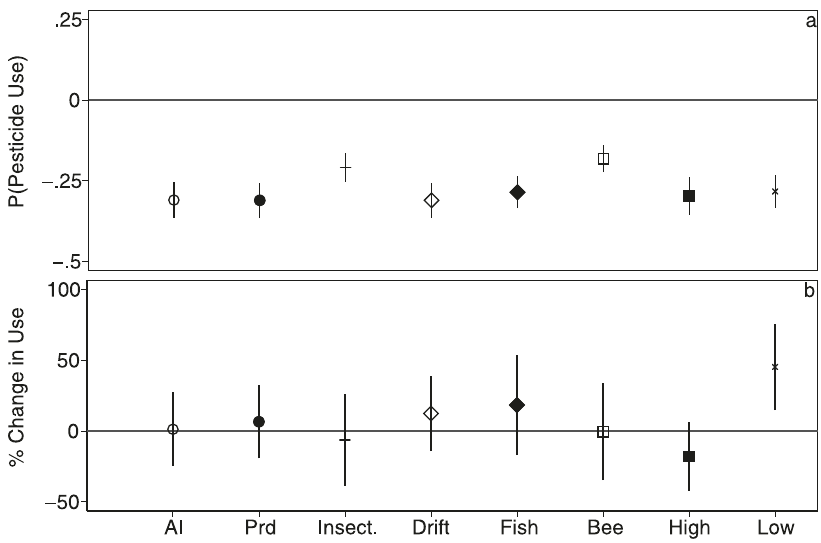
Fig. 4 Lognormal hurdles models correcting for estimated yield gaps following Ponisio et al. 15 . Correcting for yield gaps does not affect the fi rst hurdle ( a ), but does shift the coef fi cient estimates in the second hurdle up ( b ) relative to the unadjusted model (Fig. 2). Figure details are otherwise the same as Fig. 2. The x -axis indicates different pesticide use outcomes: kg ha − 1 active ingredients (AI), kg ha − 1 products (Prd), kg ha − 1 of products targeting insect pests only (Insect), kg ha − 1 of products with a propensity to drift (Drift), kg ha − 1 products of potential hazard to fi sh and bees (Fish, Bee), as well as products of higher (EPA signal word 1 – 2) and lower (EPA signal word 3 – 4) acute human toxicity (High, Low). Symbols indicate point estimates (mean) and error bars represent the 95% CI. All models include cluster robust standard errors clustered at the farm-by-crop family level. For the second hurdle ( b ), percent change is calculated from the log-level model as 100 ð e β (cid:2) 1 Þ and standard errors are derived using the delta-method implemented with the nlcom function in Stata. All models include covariates for fi eld size, farm size, and soil quality as well as farm-by-crop family random effects. N = 91,926 for all speci fi cations in the fi rst hurdle ( a ) and N = 68,704 (AI), N = 68,816 (Prd), N = 52,606 (Insect.), N = 67,988 (Drift), N = 60,653 (Fish), N = 48,254 (Bee), N = 61,883 (High), and N = 65,593 (Low) in the second hurdle ( b ). Coef fi cient estimates for all covariates are provided in Supplementary Table